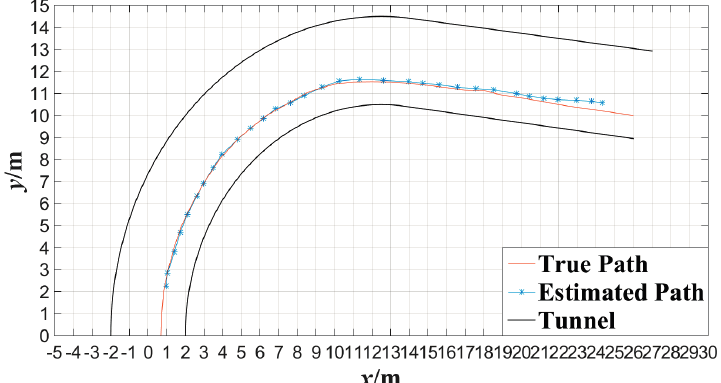
Figure 16. Trajectory of broken line tracked with the miner’s lamp video collaborative localization.